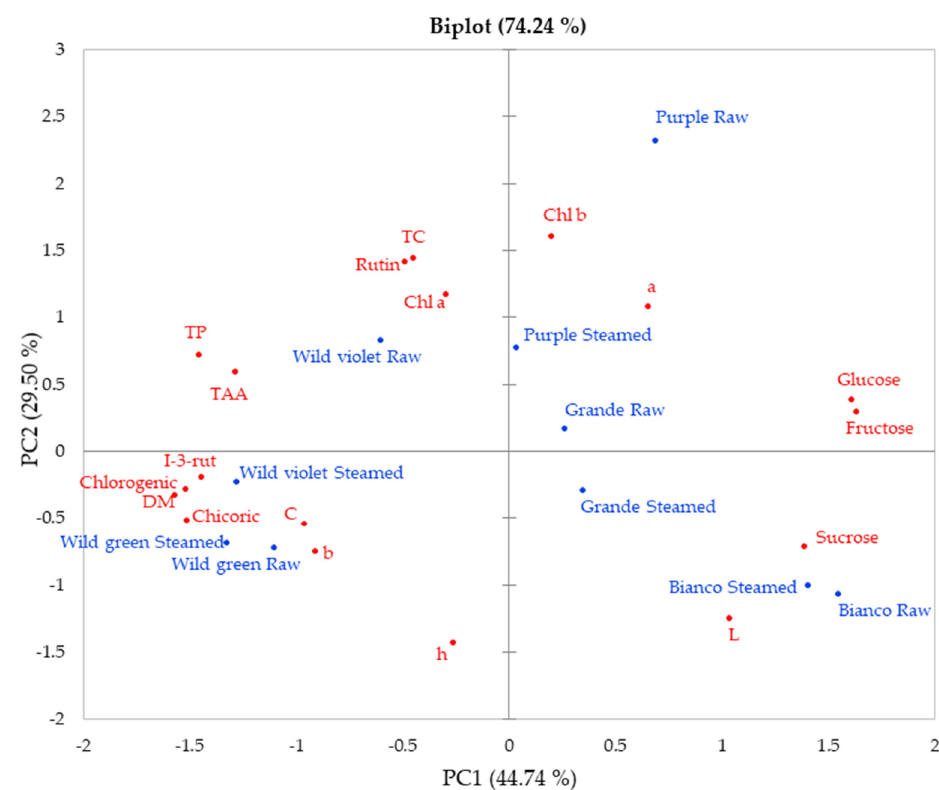
Figure 7. PCA biplot (PC1 vs. PC2) describing the distribution of the chemical-physical parameters in relation to the asparagus genotypes and their status (raw or steamed). DM, dry matter; L, brightness; a* , redness; b* , yellowness; h°, hue angle; C, saturation; TAA, total antioxidant activity; TP, total phenolics; Chlorogenic, chlorogenic acid; Chicoric, chicoric acid; I-3-rut, I-3-rutinoside; Chl a, chlorophyll a; Chl b, chlorophyll b; TC, total carotenoids; Grande, ‘Grande’; Purple, ‘Purple Passion’; Bianco, ‘Bianco di Bassano del Grappa’